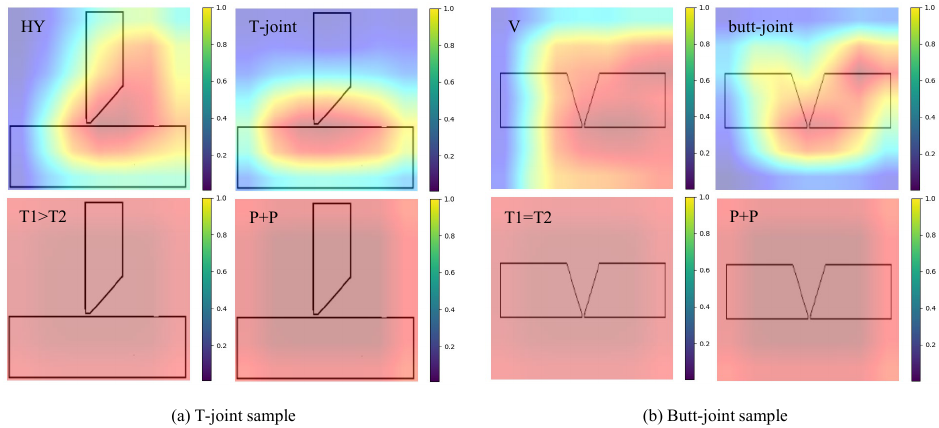
Figure 5. Predicted heat map of welded joint sketch category: ( a ) is the sample result of the T-joint, and ( b ) is the sample result of the butt joint.